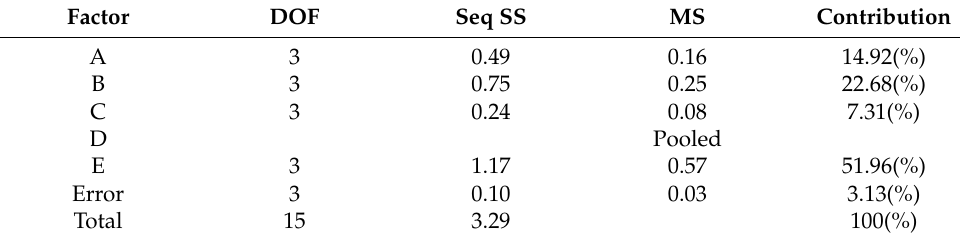
Table 9. Variance Analysis of Total Warpage